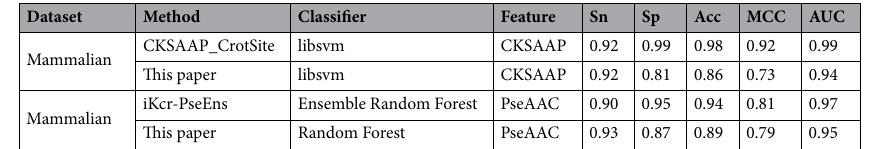
Table 4. Performance comparison between our method and other two existing tools (CKSAAP_CrotSite and iKcr-PseEns). The above comparison indicated that our study works competitively good as these two published work.